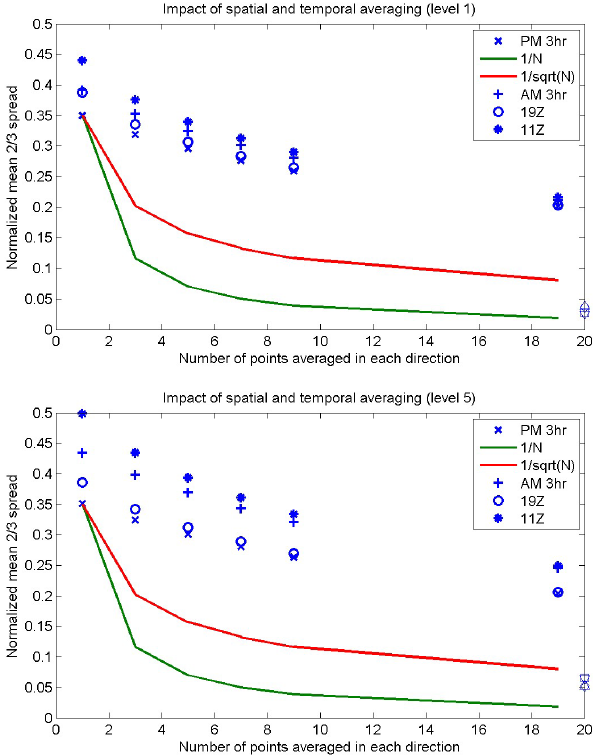
Figure 15. CO tracer spread as a function of averaging for sur- Figure 15: CO tracer spread as a function of averaging for surface (top) and 400-500 m AGL 580 face (top) and 400–500ma.g.l. (bottom). The points ( + and x) for (bottom). The points (+ and x) for AM and PM 3h averaging without spatial averaging are the 581 AM and PM 3h averaging without spatial averaging are the means means shown in the figures and in the second column of table 5. Points on the right axis are for 582 shown in the figures and in the second column of Table 5. Points on the right axis are for averages over the entire domain (216 × 236 averages over the entire domain (216x236 points). 583